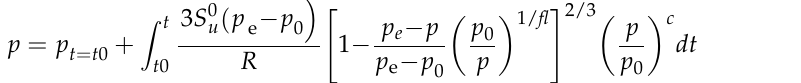
Figure 2. A typical voltage V ( t ) and current I ( t ) waveform. Ignition energy E ig = 29 mJ, and pulse duration ( t 2 − t 1 ) ≈ 1.5 µ